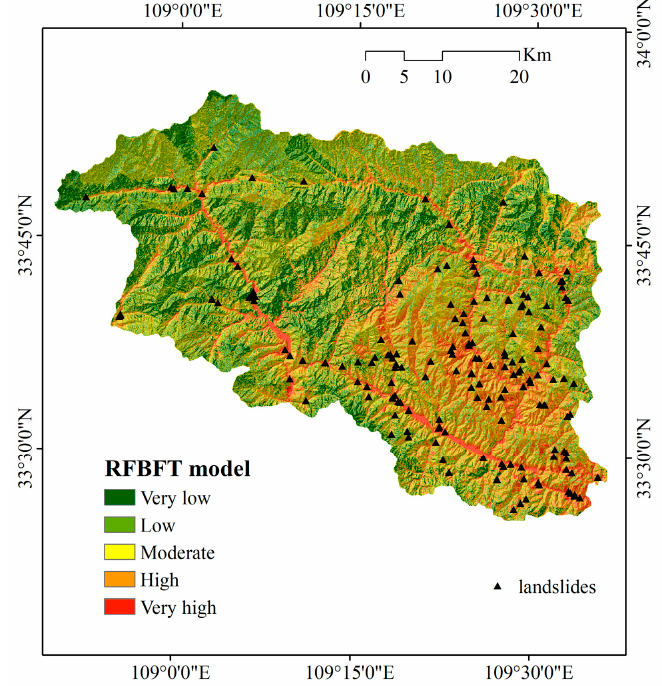
Figure 6. Landslide susceptibility map using RFBFT model.